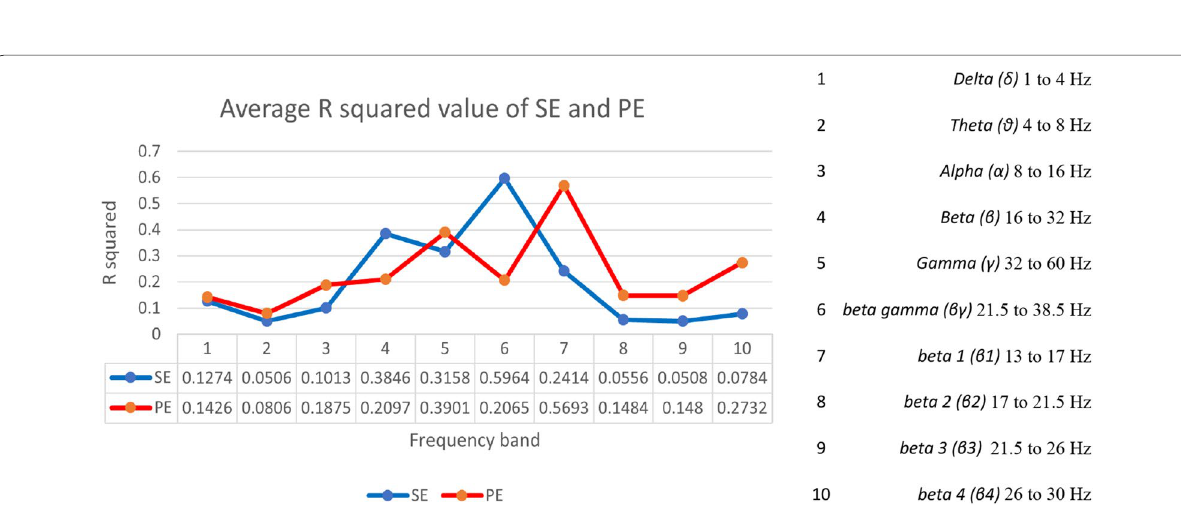
Fig. 4 Comparison between SE and PE from different frequency bands (the reference is the BIS index)